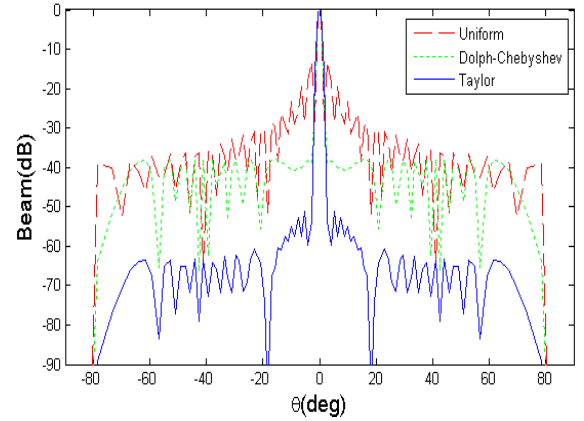
Figure 7. CMUT linear array directivity diagram after weighted